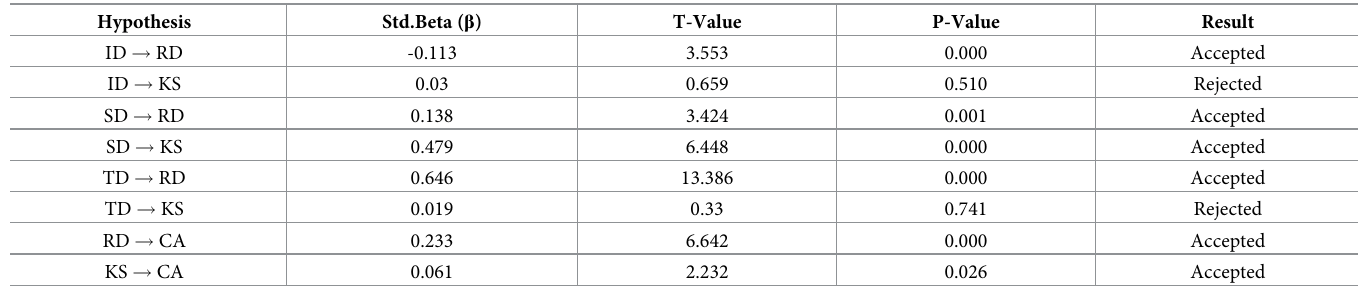
Table 6. Test of hypothesis (Direct effect).